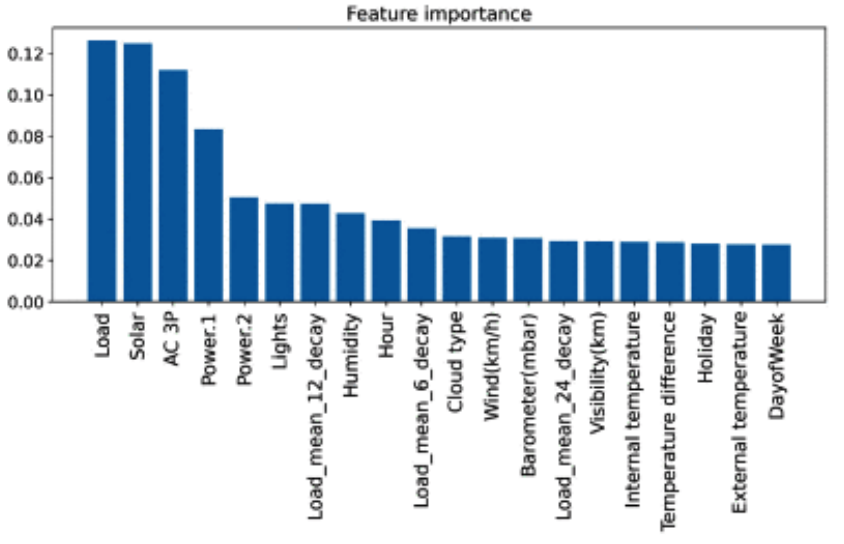
Figure 9. The implementation process of the IM-LSTM network [144].